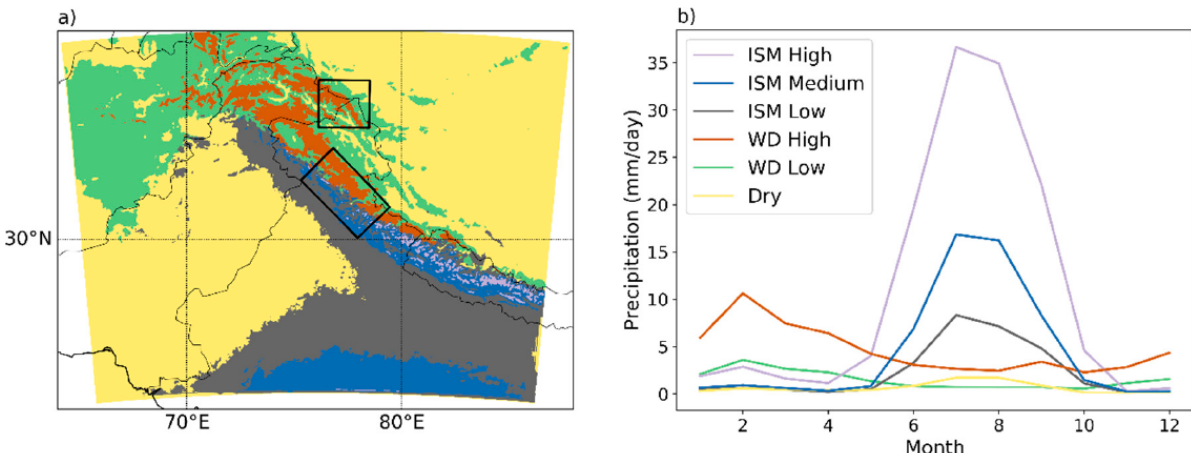
Figure 3. Precipitation regimes identified by k-means clustering ( a ), and the mean monthly precipitation (mm d − 1 ) time series for the centroid of each cluster ( b ). Black boxes in ( a ) indicate Karakoram (top) and western Himalaya (center) subregions. The colors in the legend in ( b ) apply to both